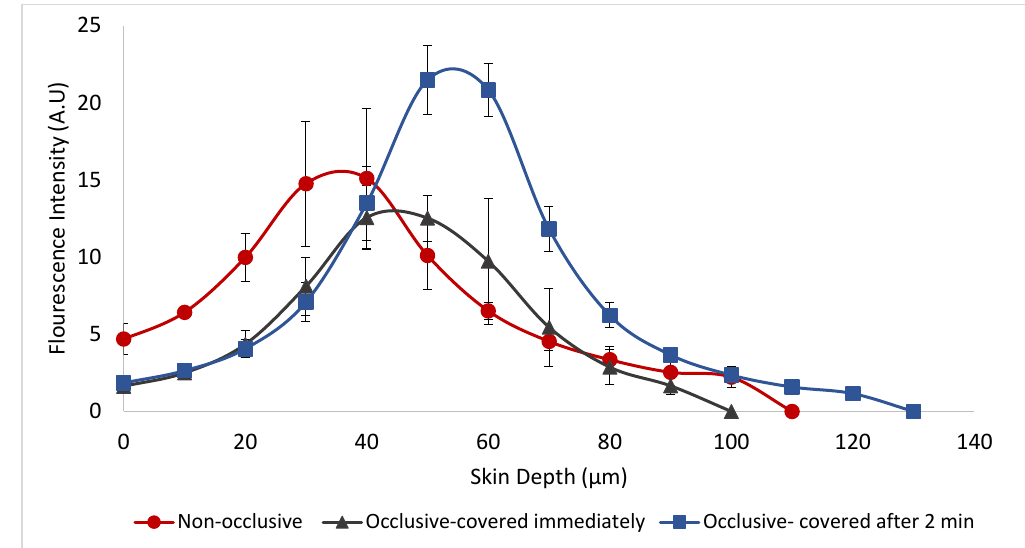
Figure 4. Mean fluorescence intensity (AU) of FITC measured following application of F7 (Cannaweb carrier) containing the probe applied: 1. Non-occlusively, 2. Occlusively, covered im- mediately, 3. Occlusively, covered 2 min after application, Mean ± SEM.